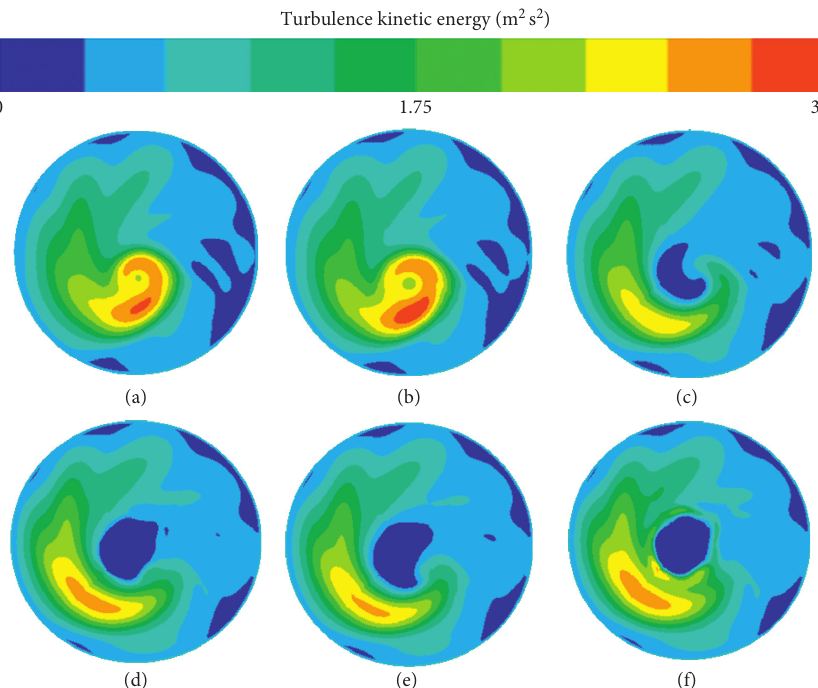
Figure 16: Cloud diagram of turbulent kinetic energy distribution at the outlet section of the nozzle. (a) Original device, (b) v � 4, (d) v � 8, (e) v � 12, (f) v � 16 (m s − 1 (c) v jet jet jet jet